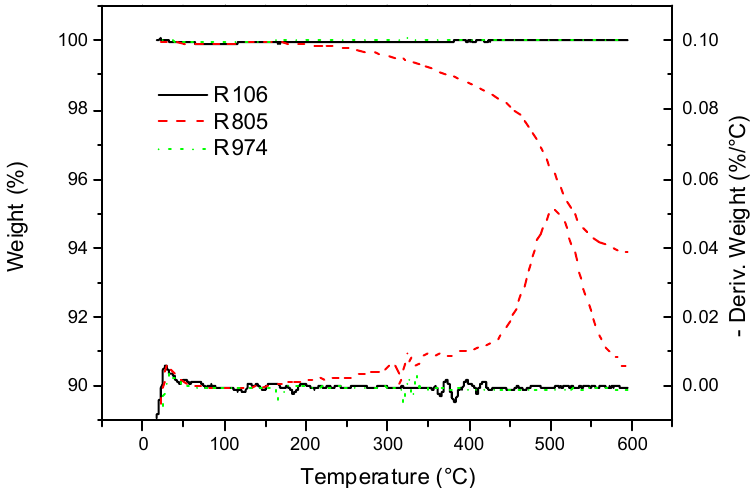
Figure 1. TGA thermograms for studied HFS samples at a heating rate of 10 ◦ C · min − 1 . Table 3. Characteristic values of weight loss from TGA for the studied samples. Degradation Temperatures (°C)